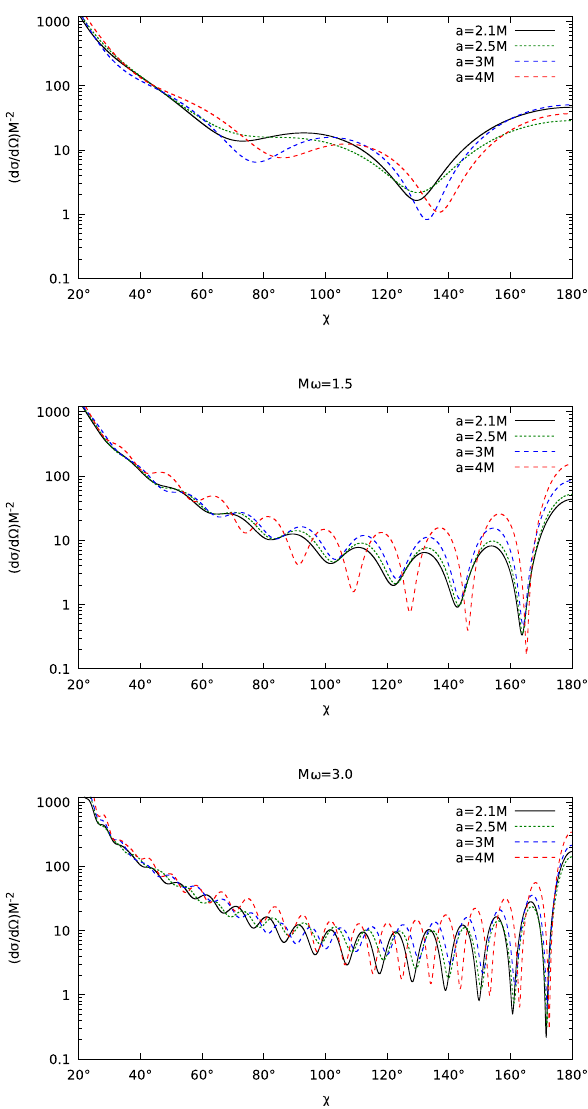
Fig. 5 The scalar differential scattering cross section of traversable wormholes described by the Simpson–Visser metric with different val- ues of the frequency and of the interpolation